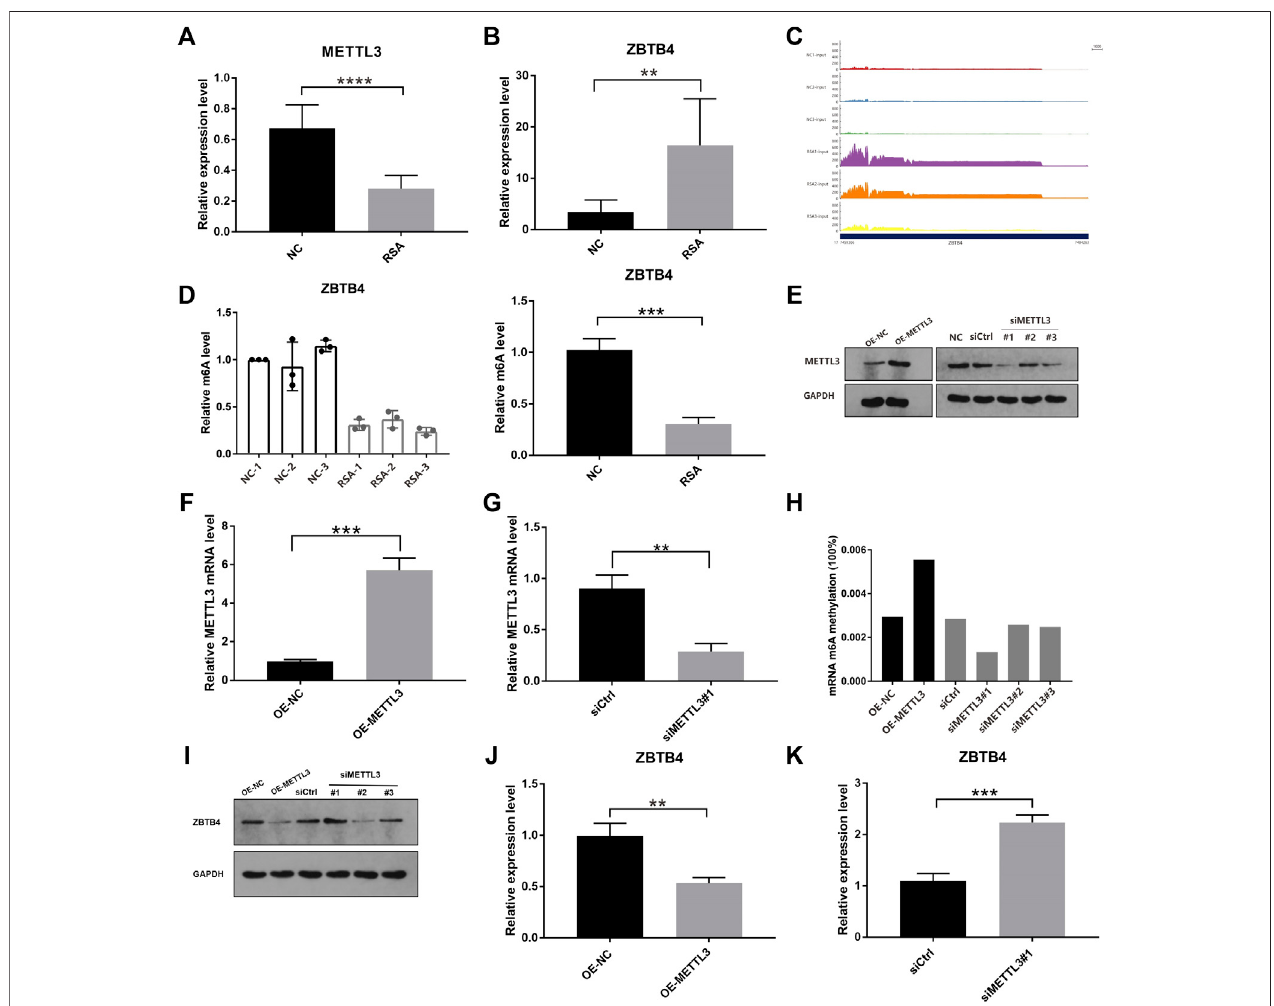
FIGURE 3 | ZBTB4 was one of the targets of METTL3 by regulating m6A modi fi cation in trophoblast. (A, B) Relative mRNA levels of METTL3 and ZBTB4 were veri fi ed by using real-time PCR in RSA and control groups. (C) RNA-seq data shows that ZBTB4 mRNA was signi fi cantly up-regulated in RSAs compared with controls and the homogeneity of ZBTB4 mRNA level between samples was better. (D) Changes of the m 6 A levels of ZBTB4 in RSA and control samples were veri fi ed by gene- speci fi c MeRIP-qPCR. (E – G) Western blotting and qRT-PCR analysis of METTL3 in HTR-8 cells with METTL3 overexpression or METTL3 knockdown. siMETTL3 oligonucleotide(#1)wasthebestoneforMETTL3knockdown. (H) RNAm 6 Amodi fi cationwasassessedusingthem 6 ARNAMethylationQuanti fi cationELISAkitinHTR- 8 cells with METTL3 overexpression or METTL3 knockdown. (I – K) Western blotting and qRT-PCR analysis of ZBTB4 in HTR-8 cells with METTL3 overexpression or METTL3 knockdown.